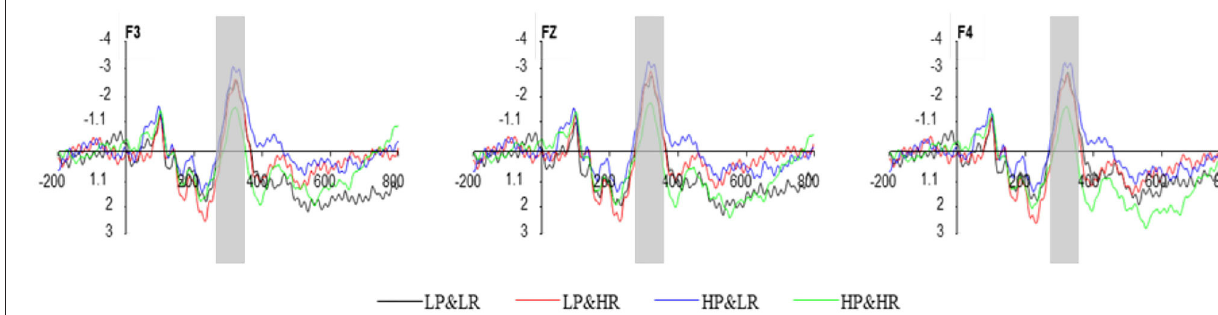
FIGURE 6 | The average waveform of N2 component at F3, Fz, and F4.